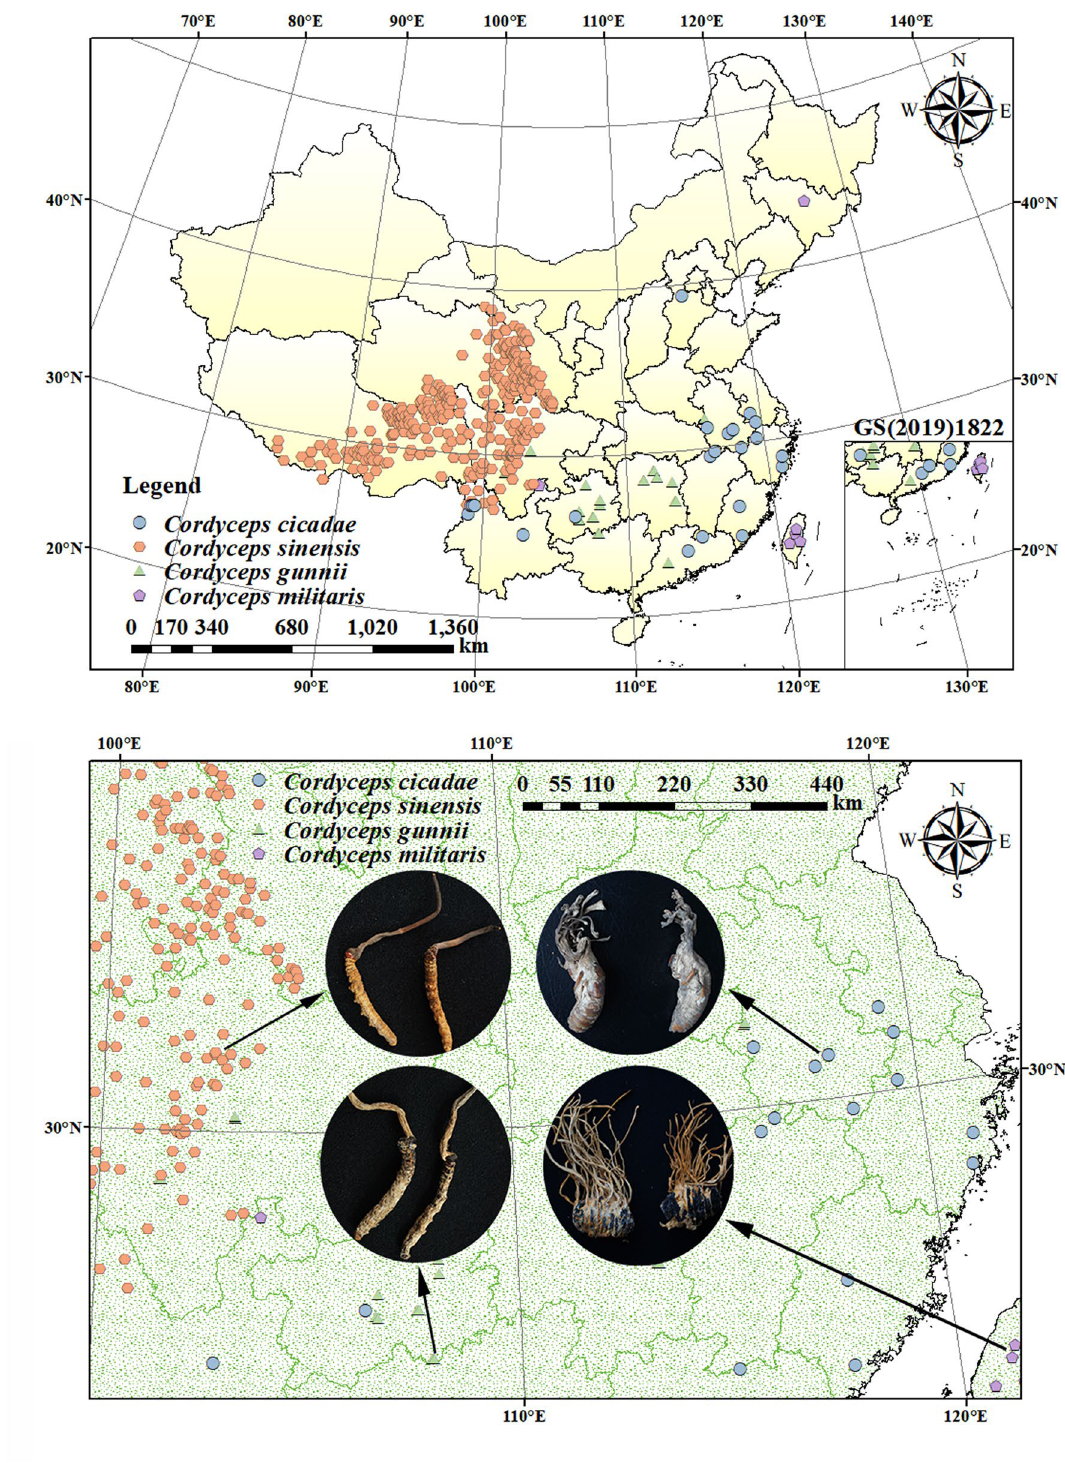
Figure 2. Species distribution point and sample photographs of C. sinensis , C. cicadae , C. militaris and C. gunnii . The figure was accomplished by ArcGIS (version 10.7, https:// www. esri. com/ zh- cn/ arcgis/) and